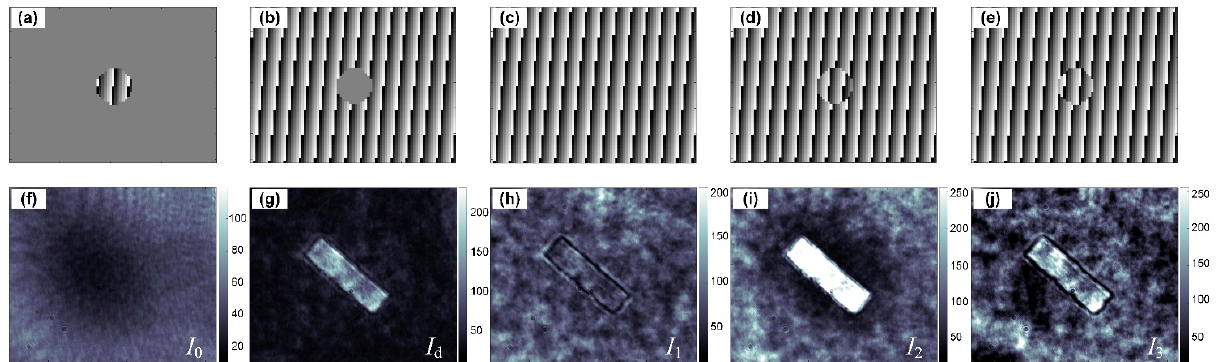
Figure 2. Phase masks loaded on the SLM and the intensity images recorded by CCD 2 . ( a – e ) Grating- based phase masks loaded on a SLM for PCI-QPCM imaging. ( a ) Central grating; ( b ) surrounding grating; ( c – e ) phase masks to generate the interferograms with phase shifts of 0, 2 π /3, and 4 π /3 between the undiffracted and diffracted components, respectively; ( f – j ) the raw intensity image obtained when loading the phase masks in ( a – e ) to the SLM. ( f – g ) The intensity images of the undiffracted and diffracted components; ( h – j ) phase-shifting interferograms with phase shifts of 0, 2 π /3, and 4 π /3 between the undiffracted and diffracted components, respectively.